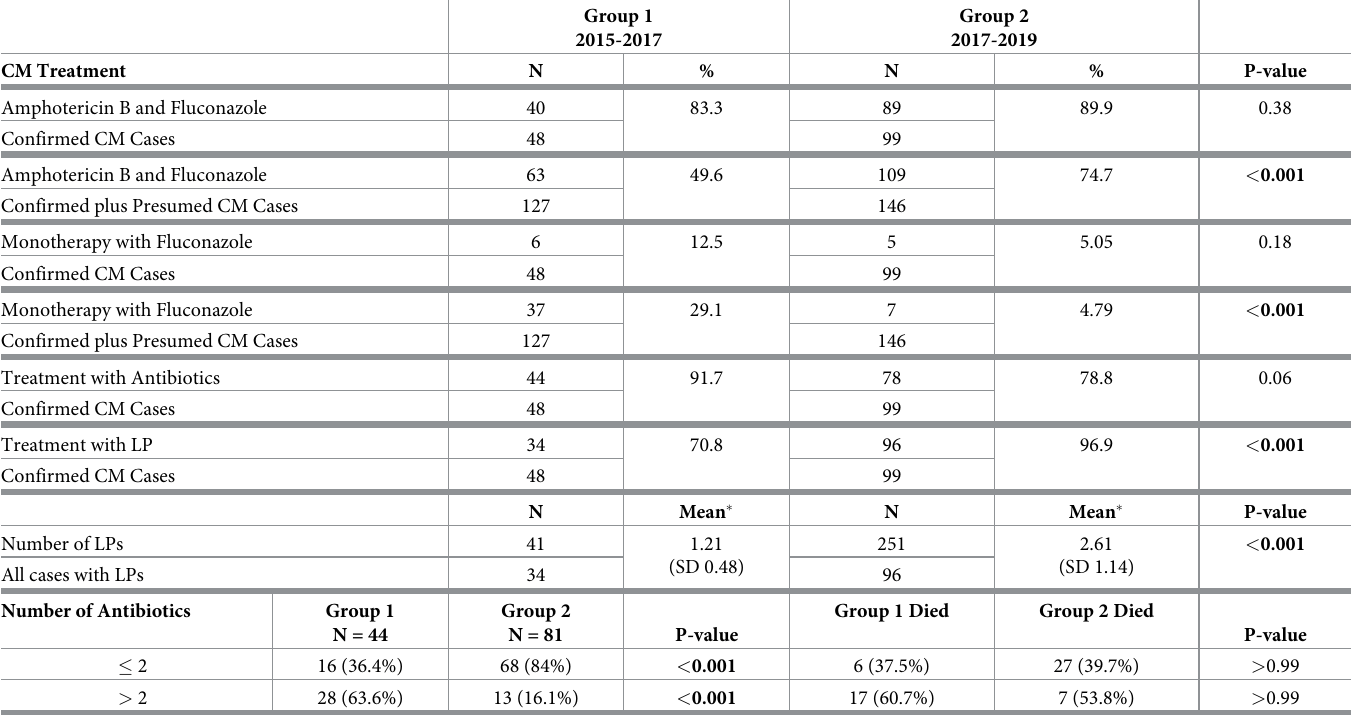
Table 5. Impact of the CM-DTP on